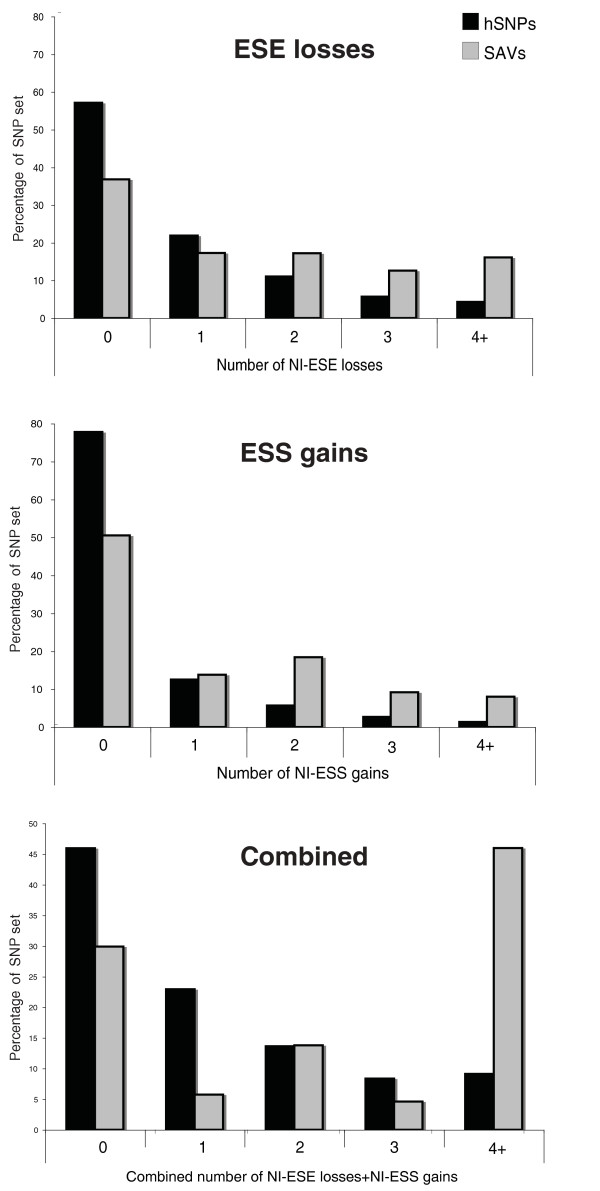
Splice-affecting genome variants are characterized by losses of large numbers of NI-ESEs and the gain of large numbers of NI-ESSs, often in combination. For both ESE losses and ESS gains, the proportion of SAVs with changes of two or more were significantly greater compared to hSNPs. Combinations of ESE losses and ESS gains, as opposed to each occurring independently, are highly enriched in SAVs compared to hSNPs (bottom graph).